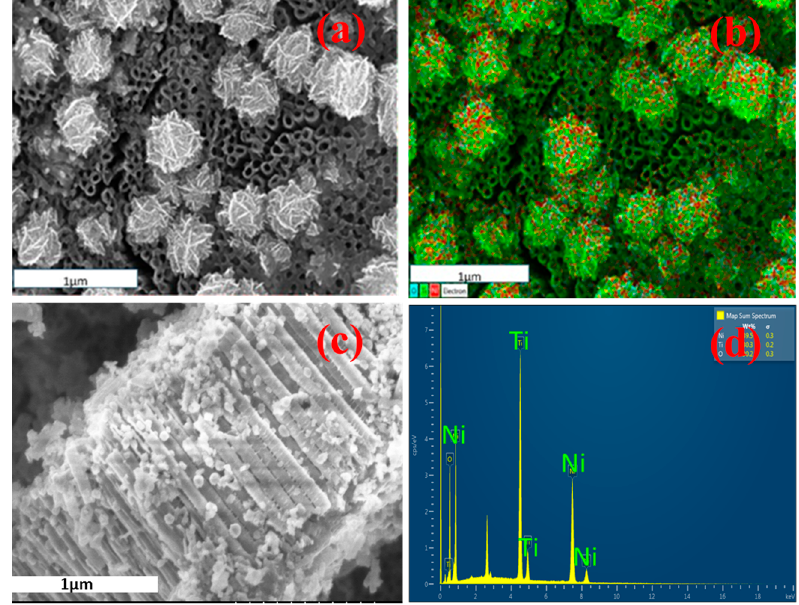
Figure 2. SEM image of ( a ) electrodeposited Ni on TNA; ( b ) EDS micrograph confirming the presence of Ni globules on TNA; ( c ) Ni globules present on the side wall of the nanotubes, ( d ) EDS spectrum further confirming the presence of Ni.